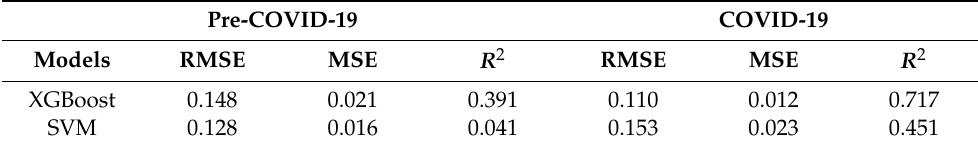
Table 3. A prediction performance assessment of the candidate models (weekly analysis).